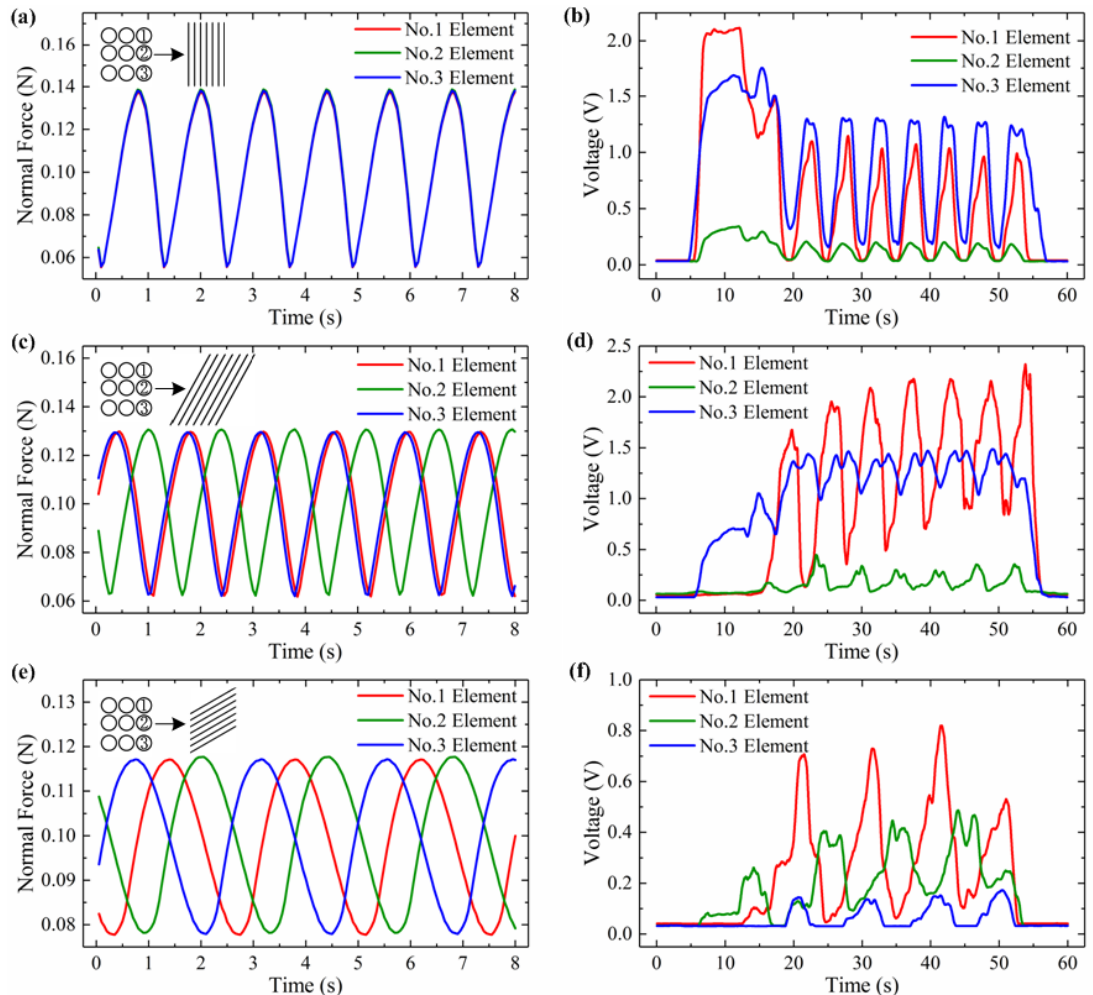
Figure 10. Simulated normal force curves when the sensor array is sliding along the grooved surface with an inclined angle α equal to ( a ) 0°, ( c ) 30° and ( e ) 60°. Measured voltages from the validation test for inclined angle calculation when α equals ( b ) 0°, ( d ) 30°, ( f ) 60°.